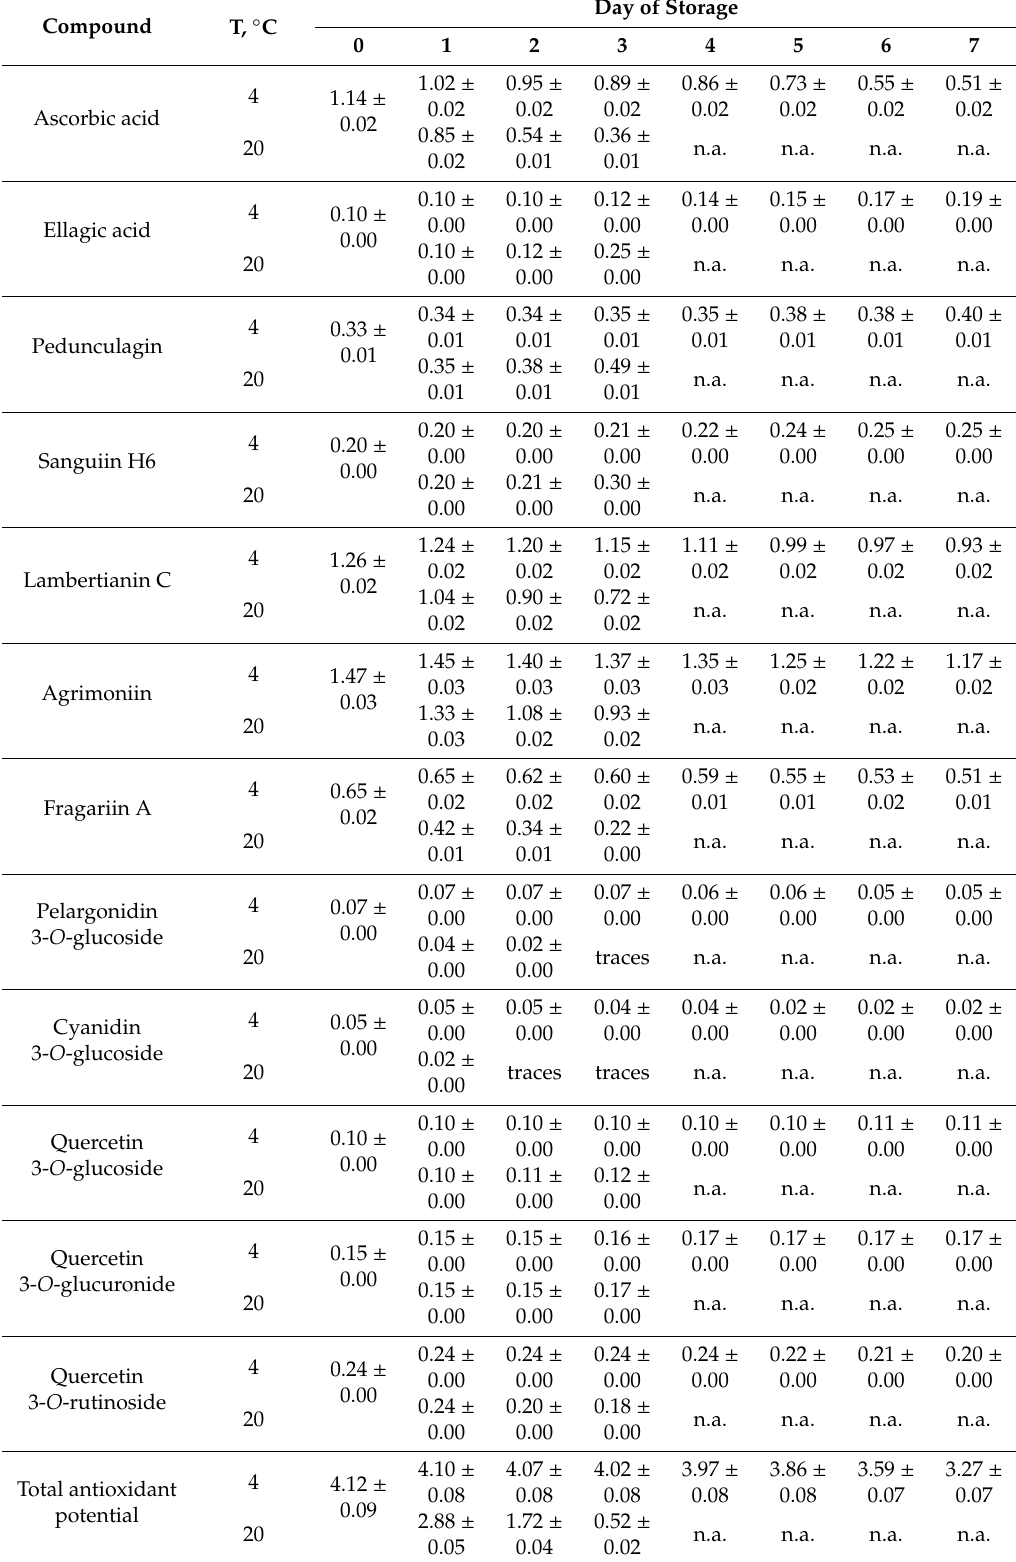
Table 4. Content of selected antioxidants in ripe fruits of F. viridis (mg / g of fresh fruit weight ± S.D.) and its total antioxidant potential (coulometric titration assay; µ mol trolox-eq. / g of fresh fruit weight ± S.D.) after storage at 4 ◦ C (1 week) and 20 ◦ C (3